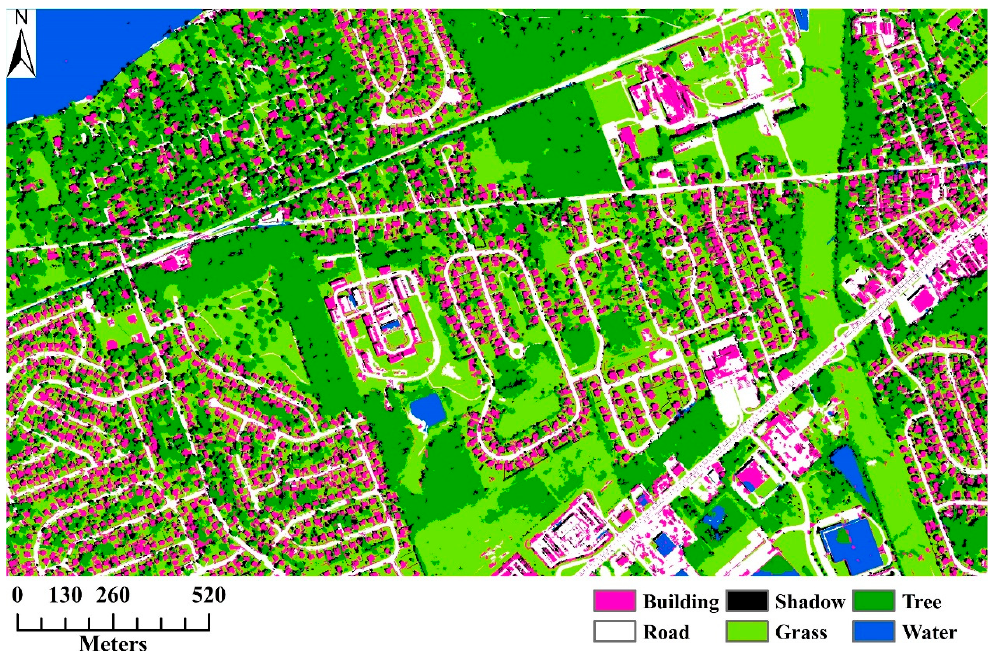
Figure A12. Classification map generated by combining classification maps of the MLP model for the 30 cm image.